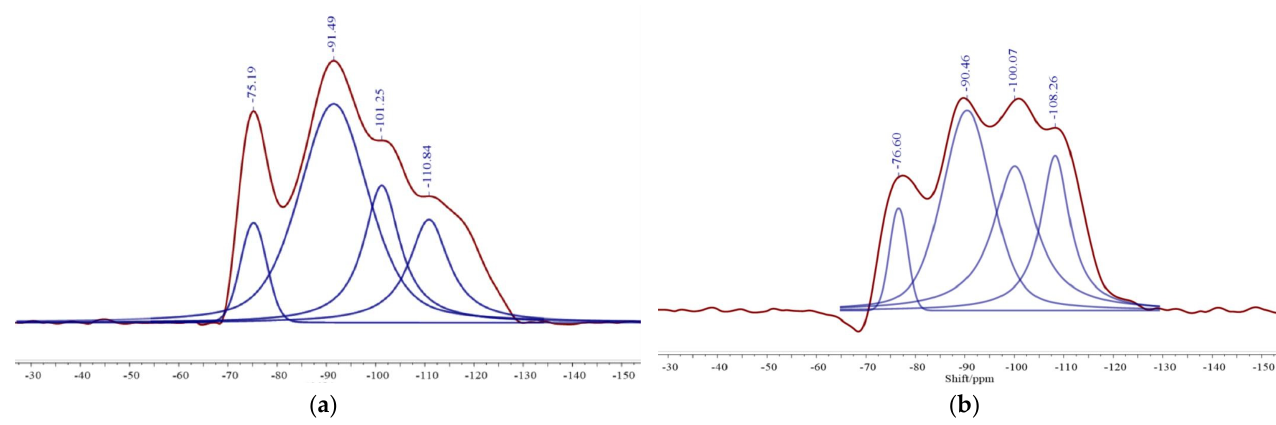
Table 7. Chemical shift range of the structure unit.